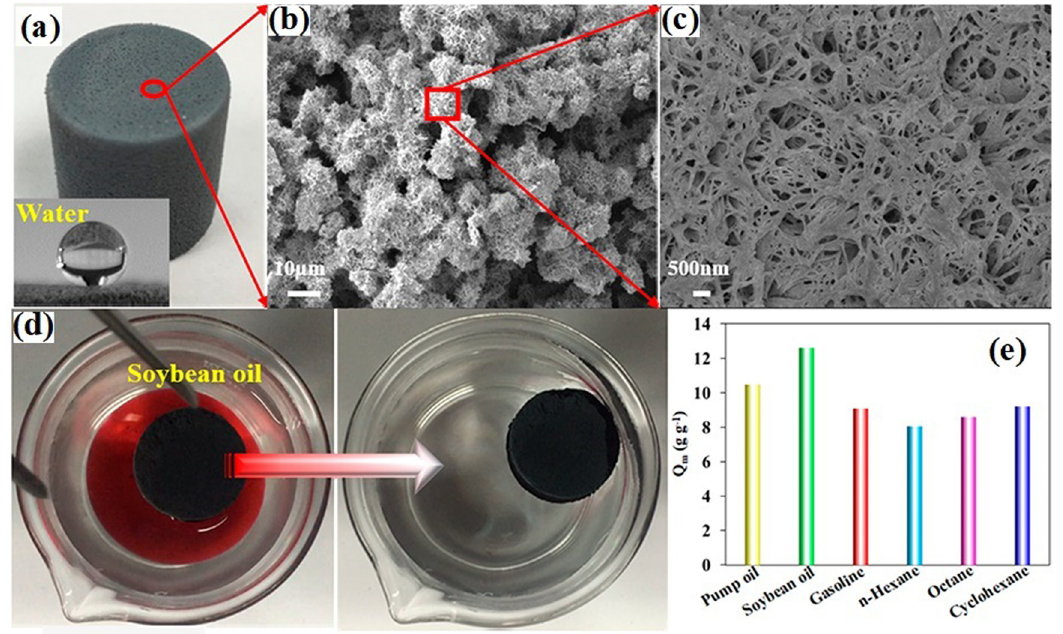
Figure 16: ( a ) Photograph and ( b and c ) SEM images of PC/MWCNT monolith. ( d ) Photographs showing the separation process of oil from water surface. ( e ) Saturation adsorption capacities for various oils/solvents [ 214 ] . Reproduced with permission from ref. [ 214 ] ; © 2018 American Chemical